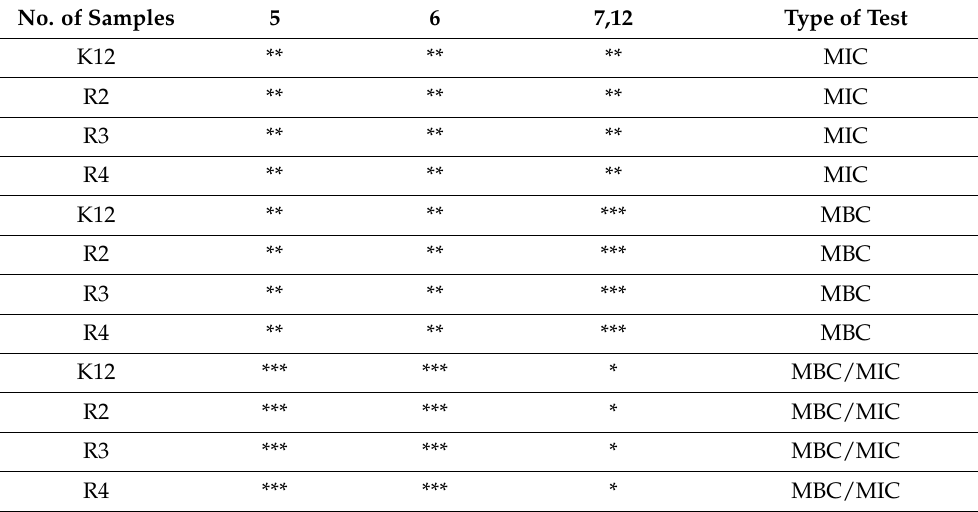
Table 2. Statistical analysis of all analyzed compounds by MIC, MBC, and MBC/MIC; <0.05 *, <0.01 **, <0.001 ***. No. of